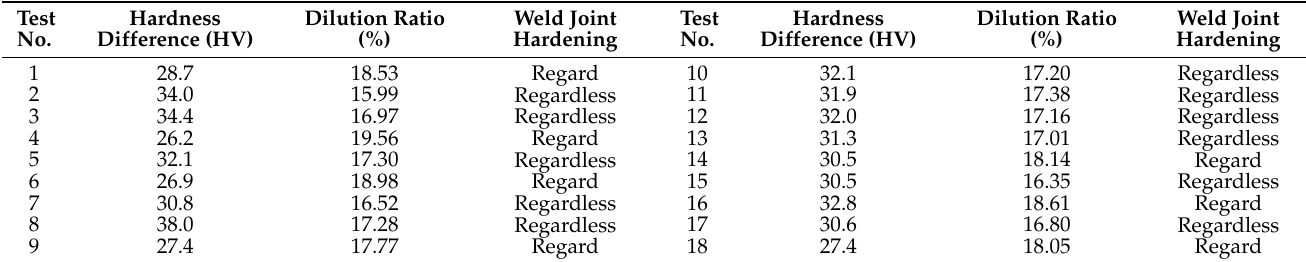
Table 8. Weld joint hardening data for discriminant analysis in fiber laser